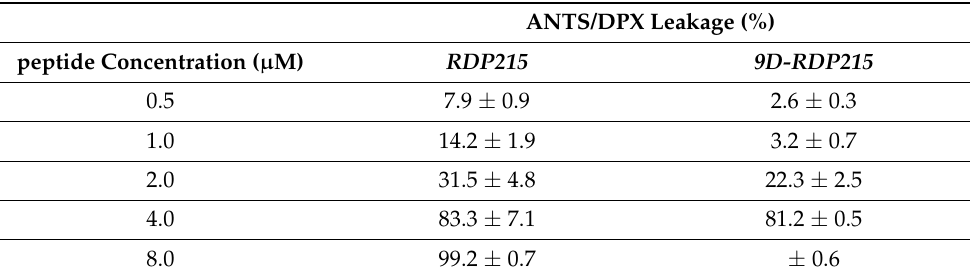
Figure 4. Membrane permeabilization of RDP215 and 9D-RDP215 on liposomes composed of cancer mimic POPS and non- cancer mimic POPC in ANTS/DPX leakage studies. (top). The leakage of POPS liposomes in the presence of RDP215 and 9D-RDP215. Bottom; left: The leakage of POPS and POPC liposomes in the presence of RDP215. Bottom; right: The leakage of POPS and POPC liposomes in the presence of 9D-RDP215. Mean values are given with standard deviation from at least 3 independent experiments. Both peptides show strong interaction only with the cancer mimic PS. At 8 µM peptide concentration, 99.2 ± 0.7% (RDP215, black circles) and 89.2 ± 0.6% (9D-RDP215, red circles) of ANTS/DPX is released from the POPS liposomes compared to no leakage induced on POPC liposomes (RDP215, black squares/9D-RDP215, red squares). Data represent medium values with standard deviations given of at least three independent experiments. Table 2. The mean percentage of ANTS/DPX leakage of POPS liposomes in the presence of RDP215 and 9D-RDP215 at different peptide concentrations (0.5–8 µM).